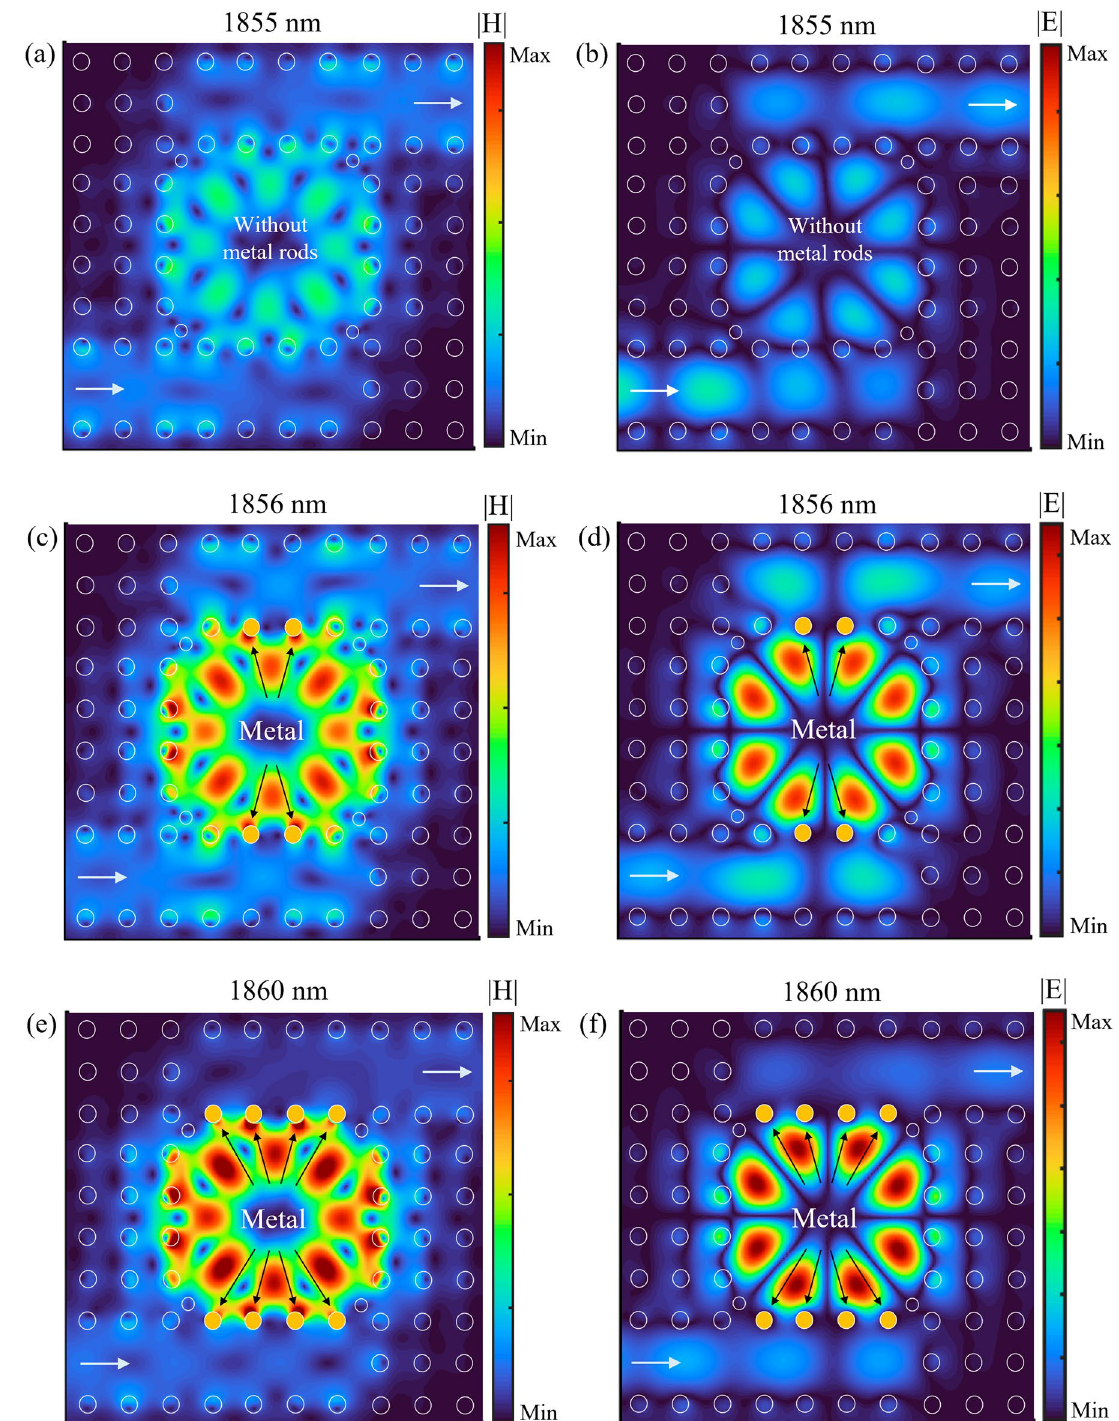
Figure 10. The distributions of magnetic and electric fields (|H| and |E|) for three RI sensor structures including ( a ) |H| for PhC sensor without metallic rods at 1855 nm, ( b ) |E| for PhC sensor without metallic rods at 1855 nm ( c ) |H| for hybrid P-PhC sensor with two metallic rods at 1856 nm, ( d ) |E| for hybrid P-PhC sensor with two metallic rods at 1856 nm, ( e ) |H| for the proposed hybrid P-PhC sensor with four metallic rods at 1860 nm, and ( f ) |E| for the proposed hybrid P-PhC sensor with four metallic rods at 1860